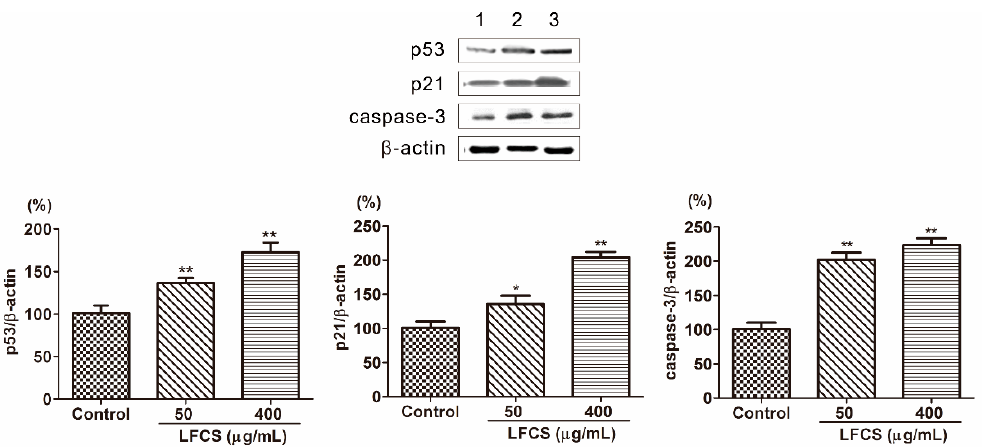
Figure 5. LFCS increased protein expression of p53, p21, and caspase-3 in LLC cells after 72 h treatment of LFCS detected by Western blot. Expression of the β -actin was used as internal control. Lane 1: vehicle-treated cells; Lane 2: 50 μ g/mL LFCS-treated cells; Lane 3: 400 μ g/mL LFCS-treated cells. Data were presented as mean ± SD and derived from one representative experiment performed in triplicate. * p < 0.05, ** p < 0.01, significant difference compared with control group.